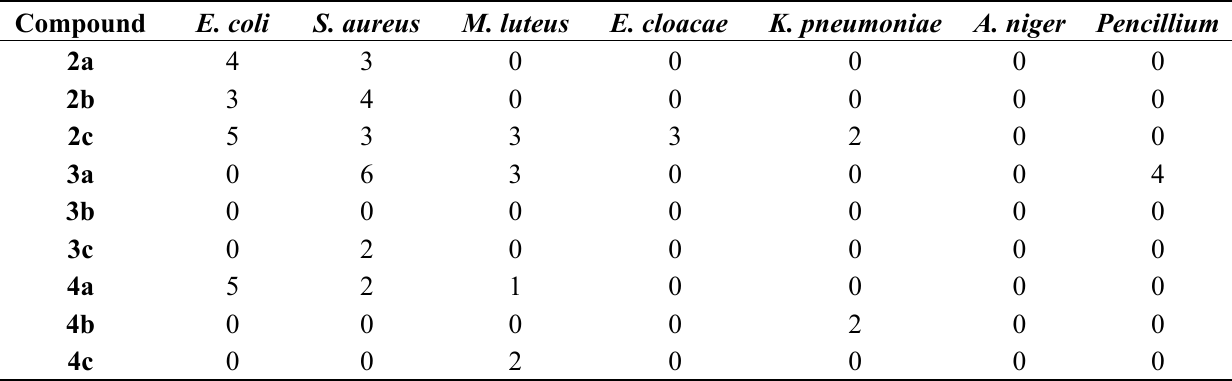
Table 1. Antimicrobial activity studies of ligands and their metal